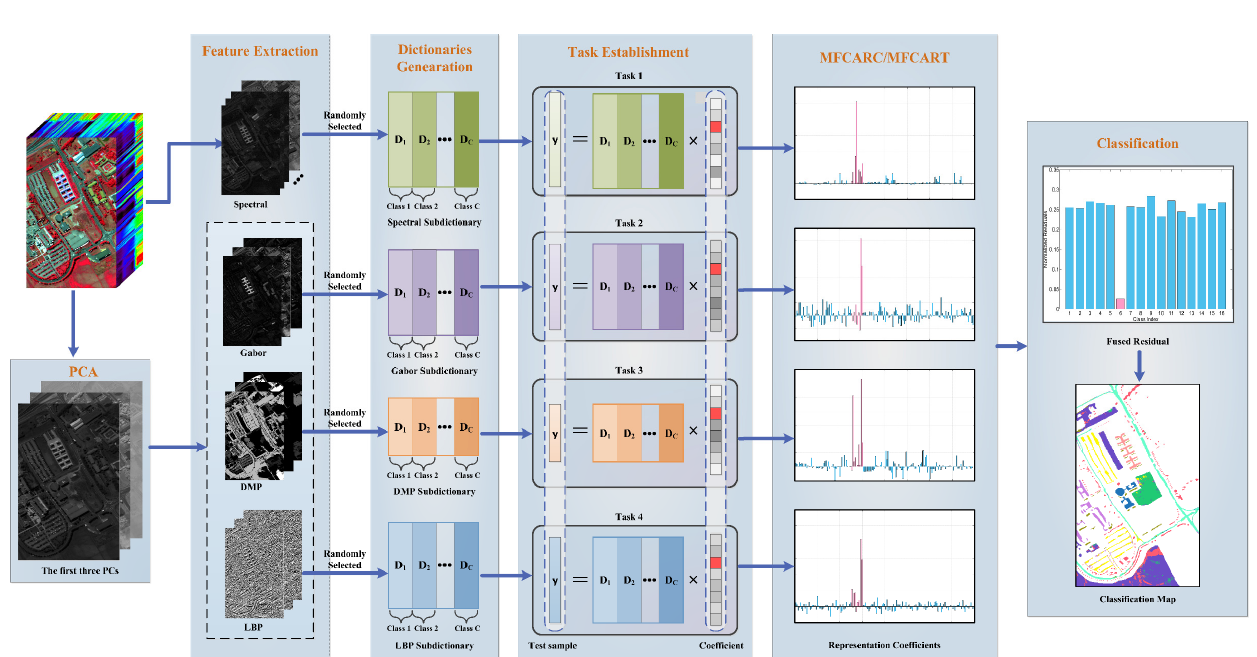
Figure 1. Schematic illustration of the proposed multi-feature correlation adaptive representation-based classifier (MFCARC) and MFCARC with Tikhonov regularization (MFCART)